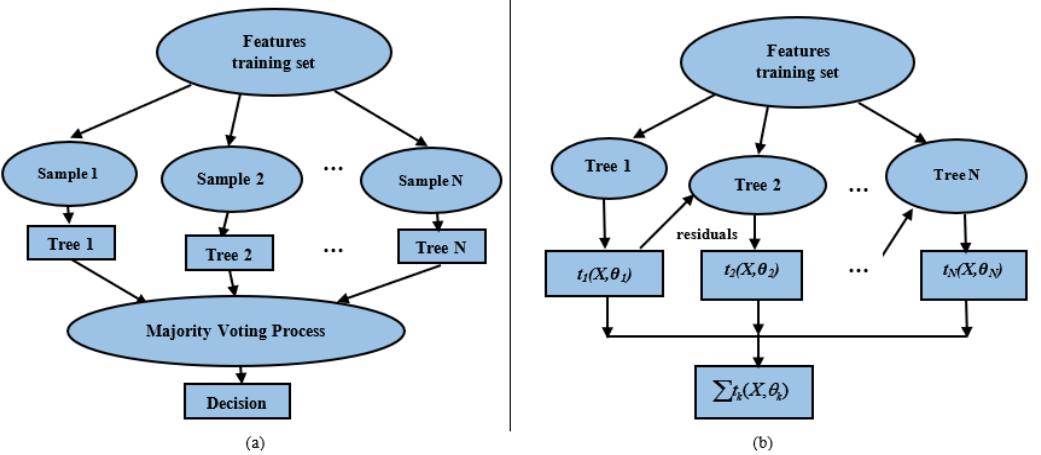
Figure 11. ( a ) Random forest and ( b ) XGBoost algorithm architectures.